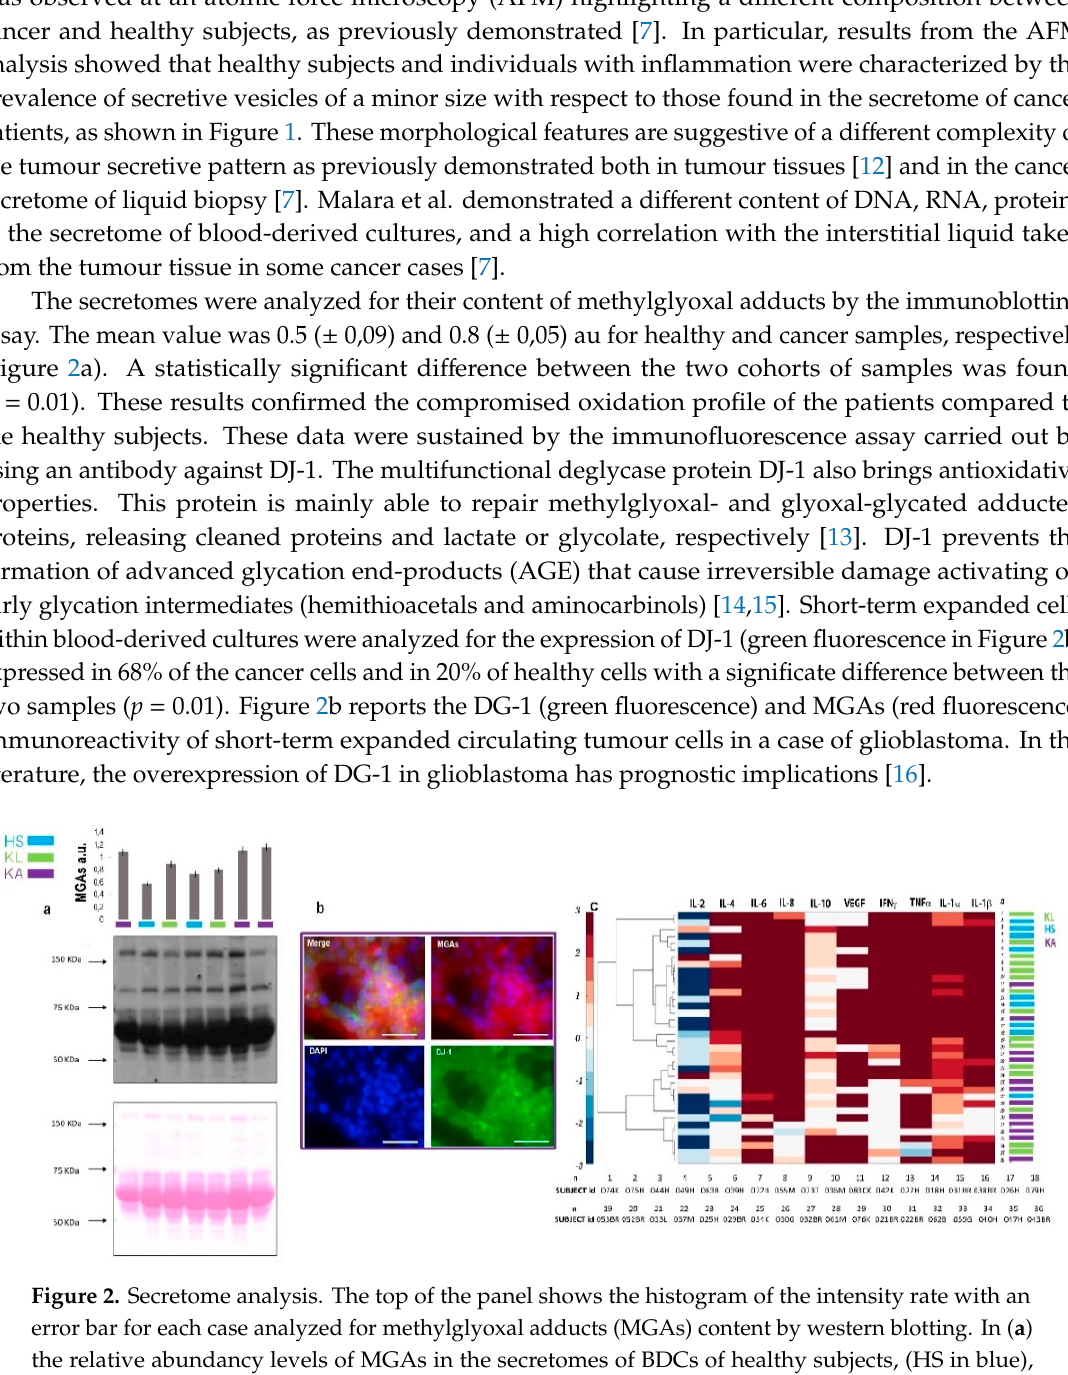
Figure 2. Secretome analysis. The top of the panel shows the histogram of the intensity rate with an error bar for each case analyzed for methylglyoxal adducts (MGAs) content by western blotting. In ( a ) the relative abundancy levels of MGAs in the secretomes of BDCs of healthy subjects, (HS in blue), localized (KL in green), and advanced cancer (KA in violet) cases. The relative amount of MGAs in the cell proteasoma has been normalized against the total protein load for each lane, stained with a Ponceau S dye and expressed as arbitrary units (au). ( b ) Immunofluorescence DJ-1 and MGAs in BDCs. Immunoreactivity is reported by a fluorescence light for DJ-1 (green) and for MGAs (red) in short-term BDCs from glioblastoma (required in violet), characterized by a prevalence of circulating tumour cells co-expressing DJ-1 and MGAs. Nuclei counterstain appears in blue fluorescence for DAPI incubation. ( c ) Hierarchical clustering based on Ward’s method grouped healthy subjects (HS) and patients with localized (KL) and advanced (KA) cancer in the function of each interleukins produced and presented in the correspondent BDCs secretome samples. Scale bars in panel (b) correspond to 50 µm.